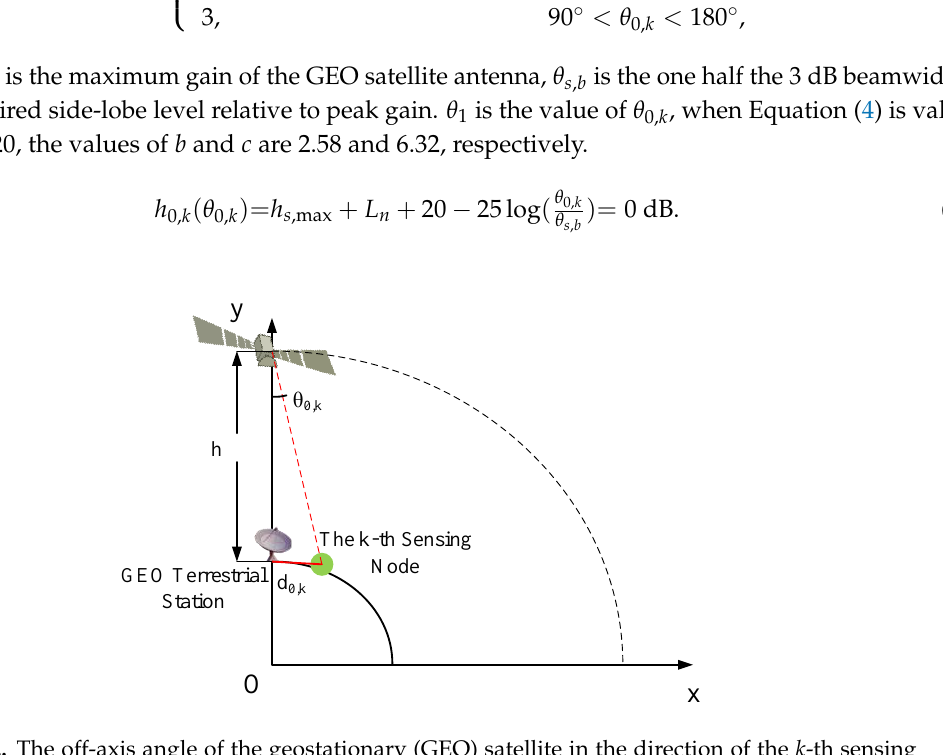
Figure 2. The off-axis angle of the geostationary (GEO) satellite in the direction of the k -th sensing node, θ 0, k